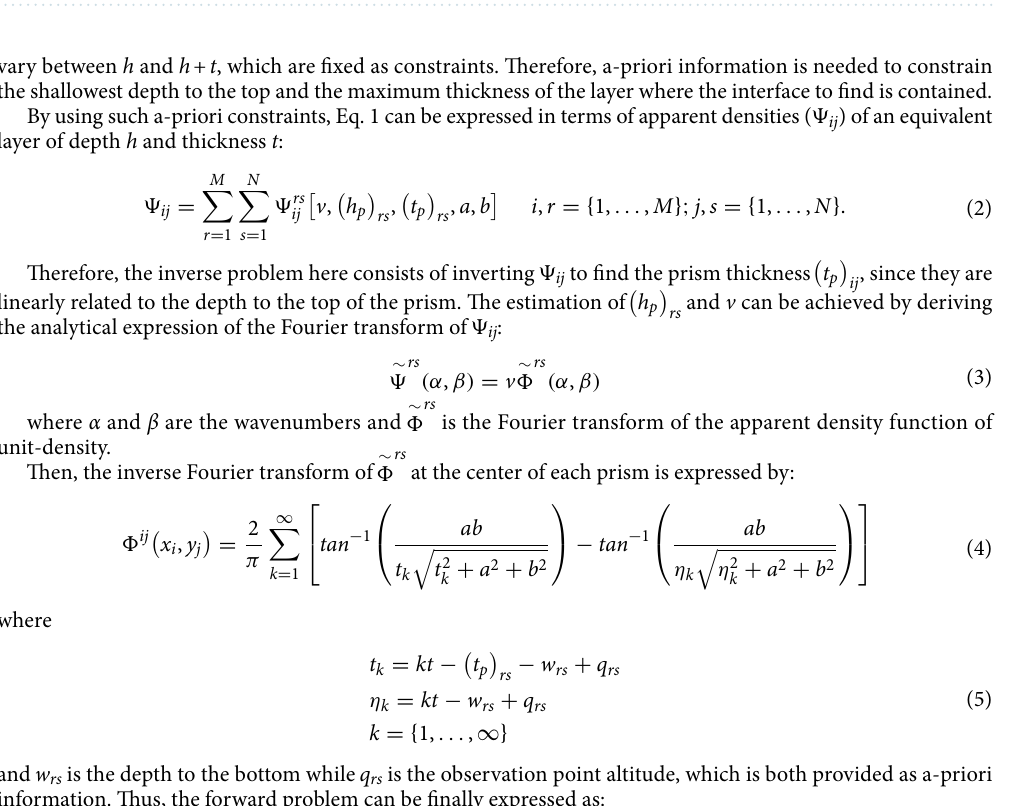
h p (modified after 61 (cid:31) (cid:30) rs